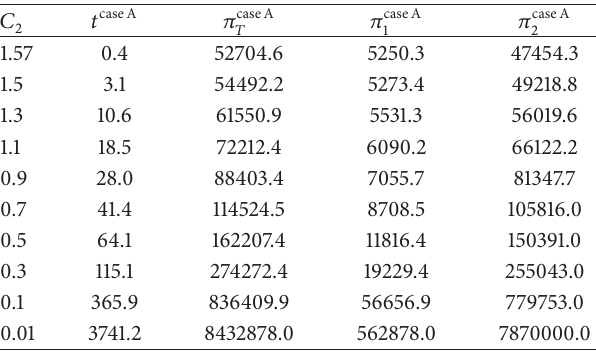
Table 3: The optimal customization degree factor and the optimal profit when the customization degree is dominated by LSI.